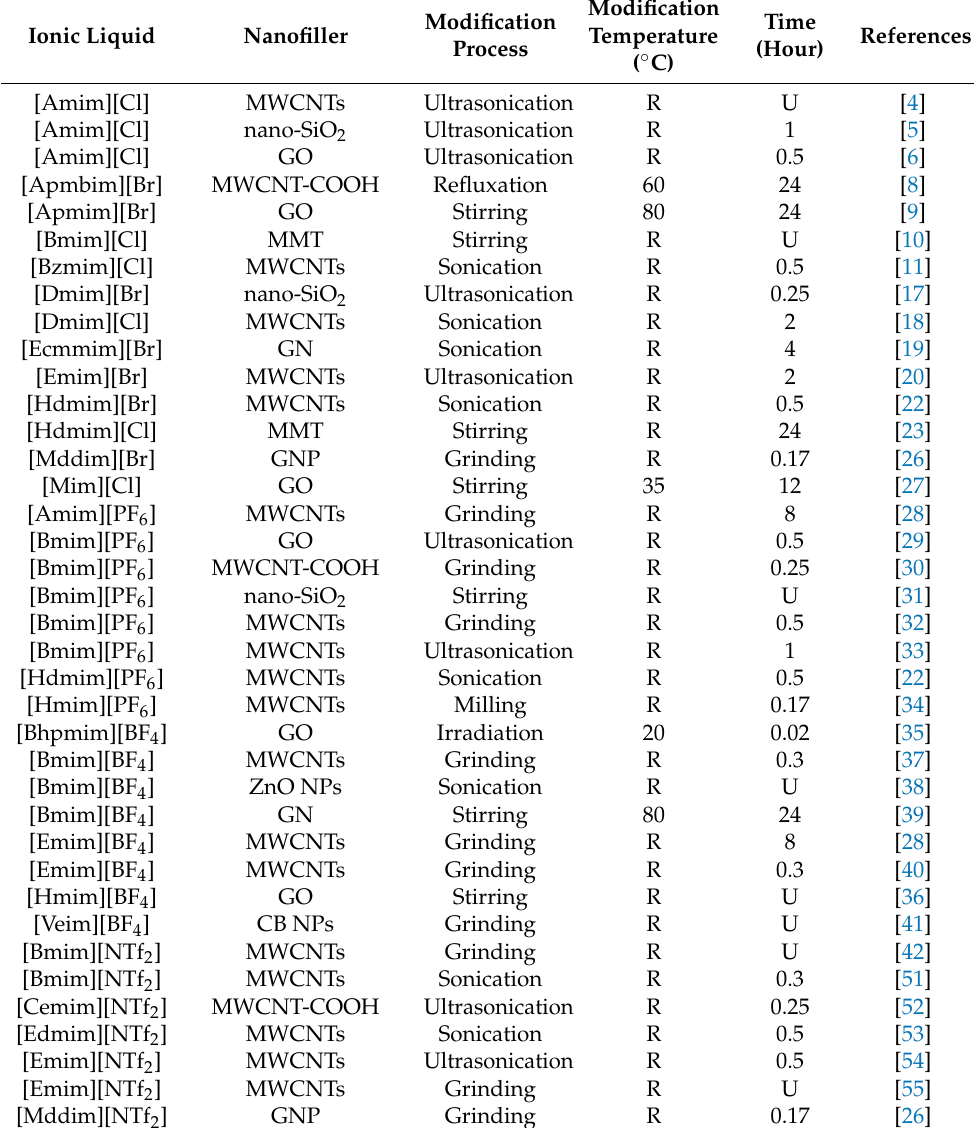
Table 3. Types of imidazolium-based ionic liquids, nanofillers, and modification processes of